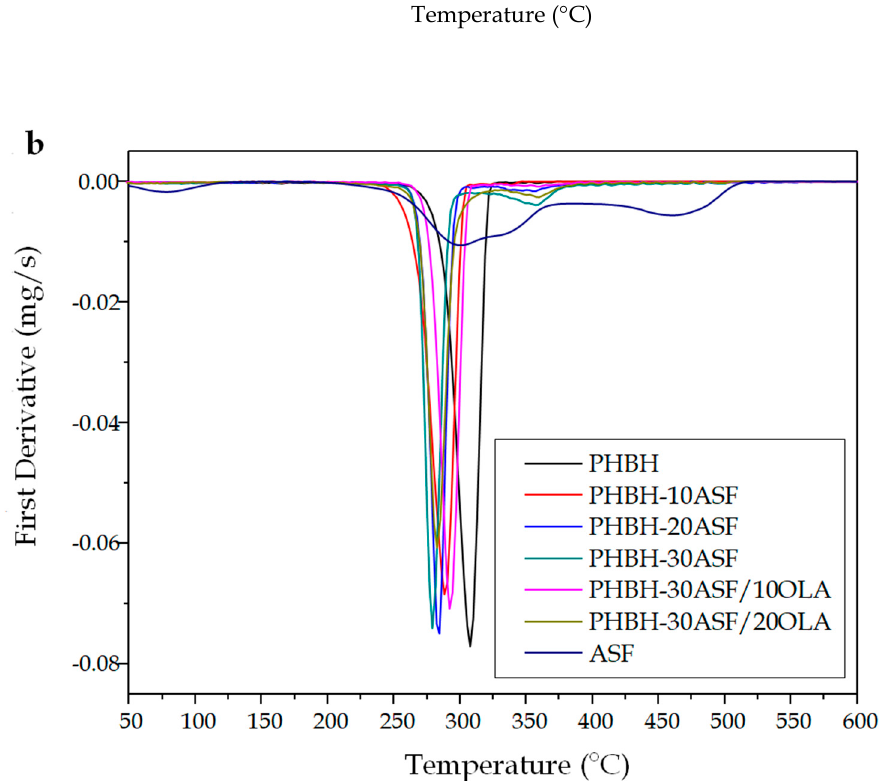
Figure 4. Comparative plot of ( a ) thermogravimetric analysis (TGA) curves and ( b ) first derivative (DTG) of the PHBH-ASF/OLA composites with different compositions.